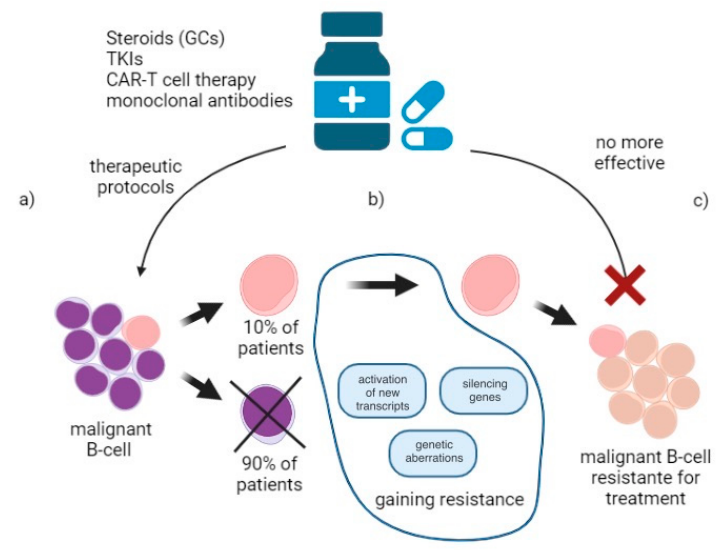
Figure 2. Response to B-ALL treatment. ( a ) Effective influence of therapeutic protocols. Patients are curable in 90% of cases, which still leaves 10% og patients resistant to therapeutic protocols; ( b ) Overcoming treatment. Cancer cells gain resistance by multiple changes in construction and activeness, such as activation of new transcripts, silencing genes, gene aberration, gene impact for expression of genes—changes observable in metabolic cell’s proteins; ( c ) Resistance to treatment. Treatment is overcome by cancer cells through genetic modifications, which protect it from the typical protocol treatment.